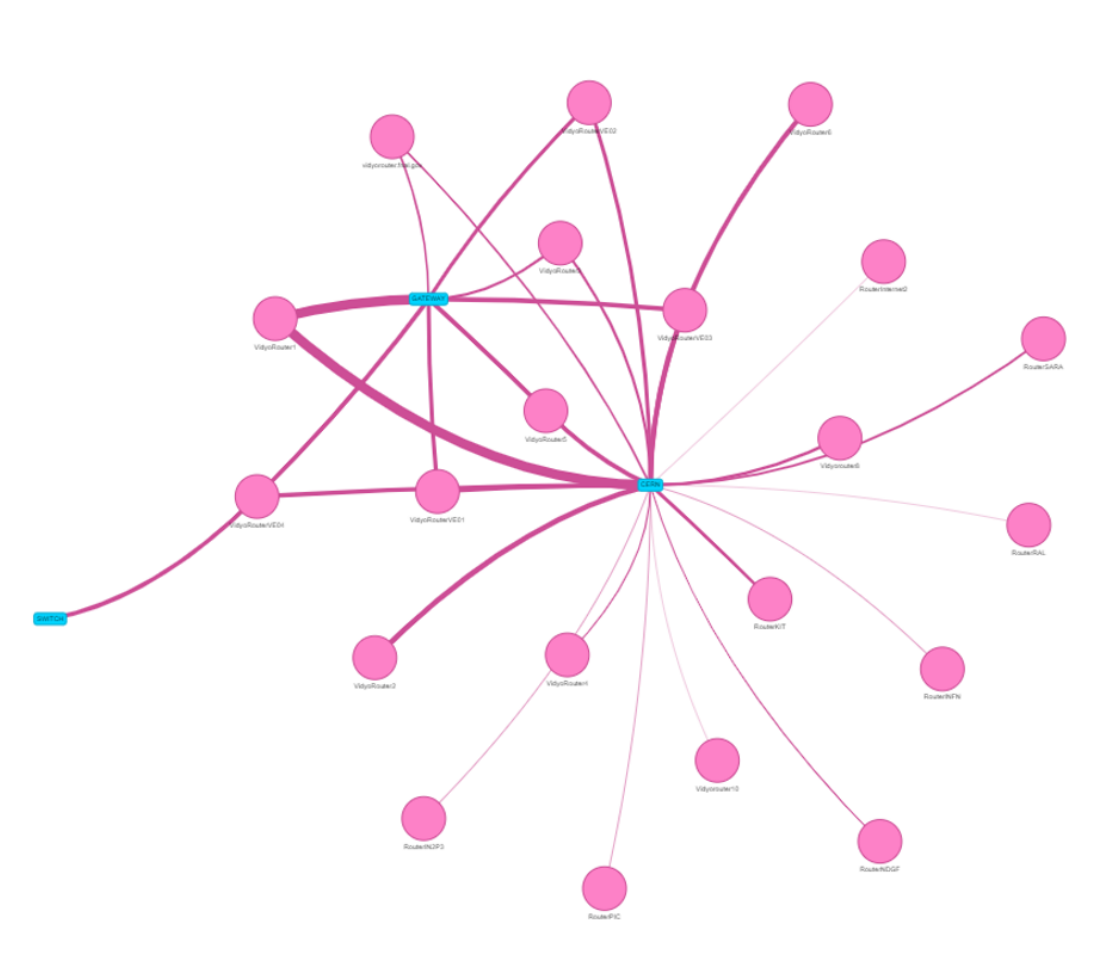
Figure 3. Online visualization of Vidyo server components utilisation: routers and